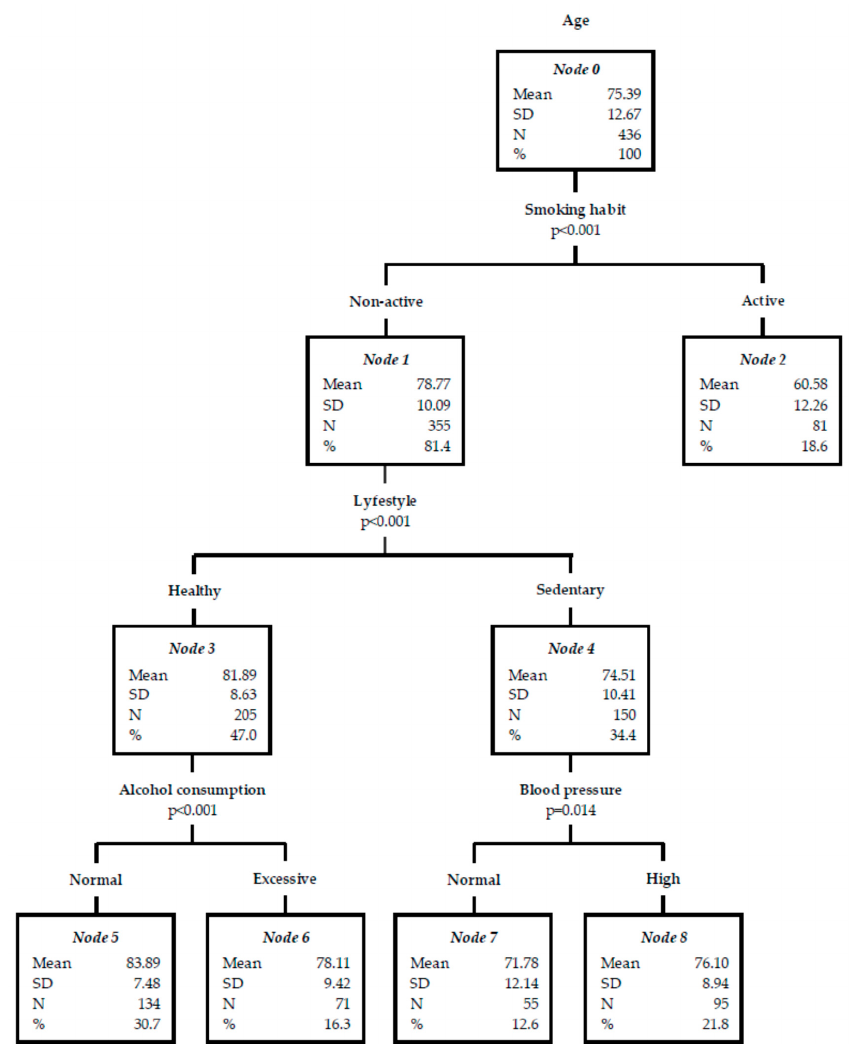
Figure 1. Decision tree for acute stroke risk factors (RFs) based on age.